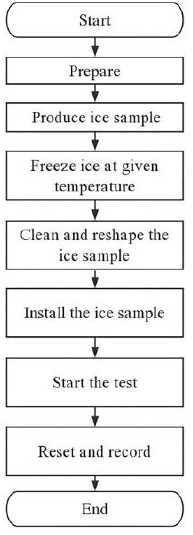
Figure 10. Flow chart of shear strength test.